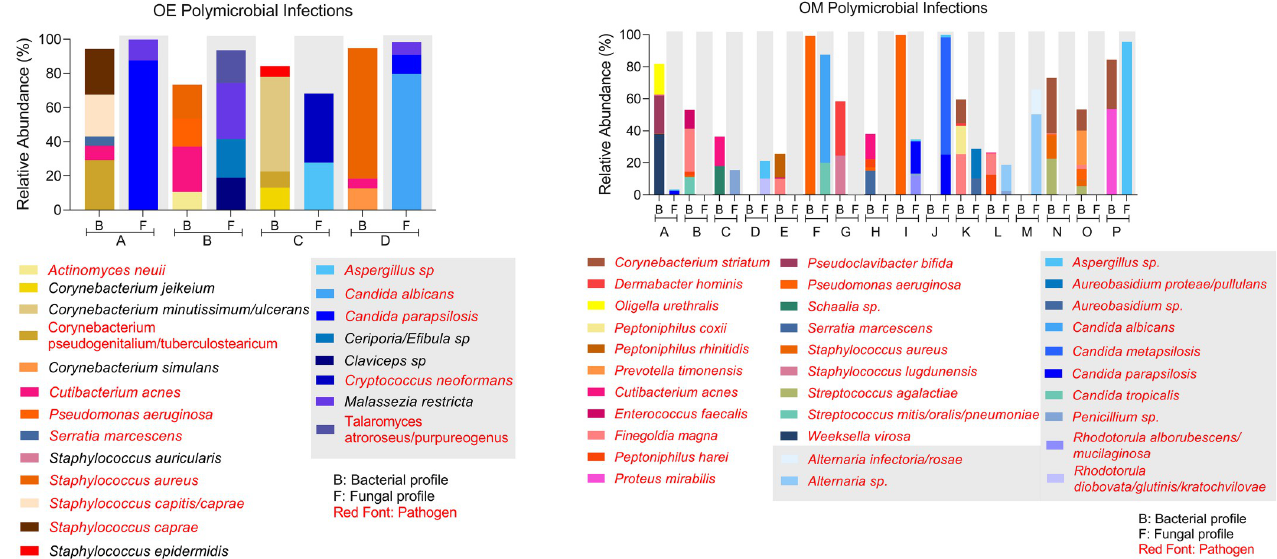
Fig 6. Poly-species infection analysis. As an example, and for brevity of the graph, the bacterial and fungal profiles of those patients that were positive for at least three bacterial otopathogens or two fungal otopathogens are shown for (A) OE and (B) OM.